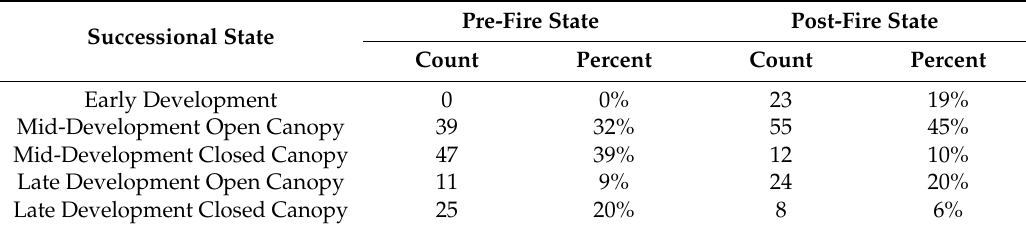
Table 6. Distribution of successional states for all 122 sampled plots according to pre-fire and post-fire successional state for all Biophysical Setting models.